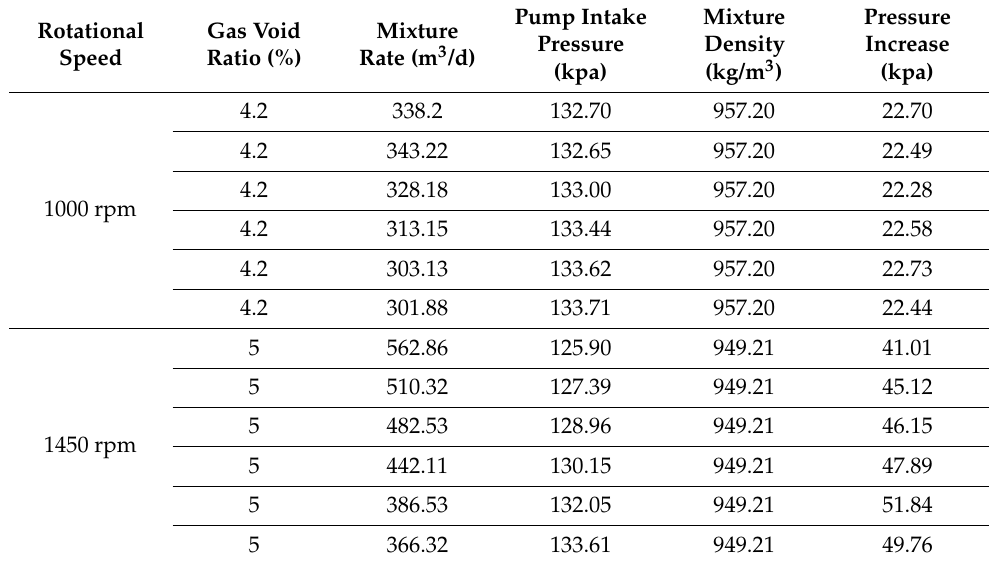
Table 4. Test data of single-stage radial flow pump at two different rotational speeds and gas void ratios